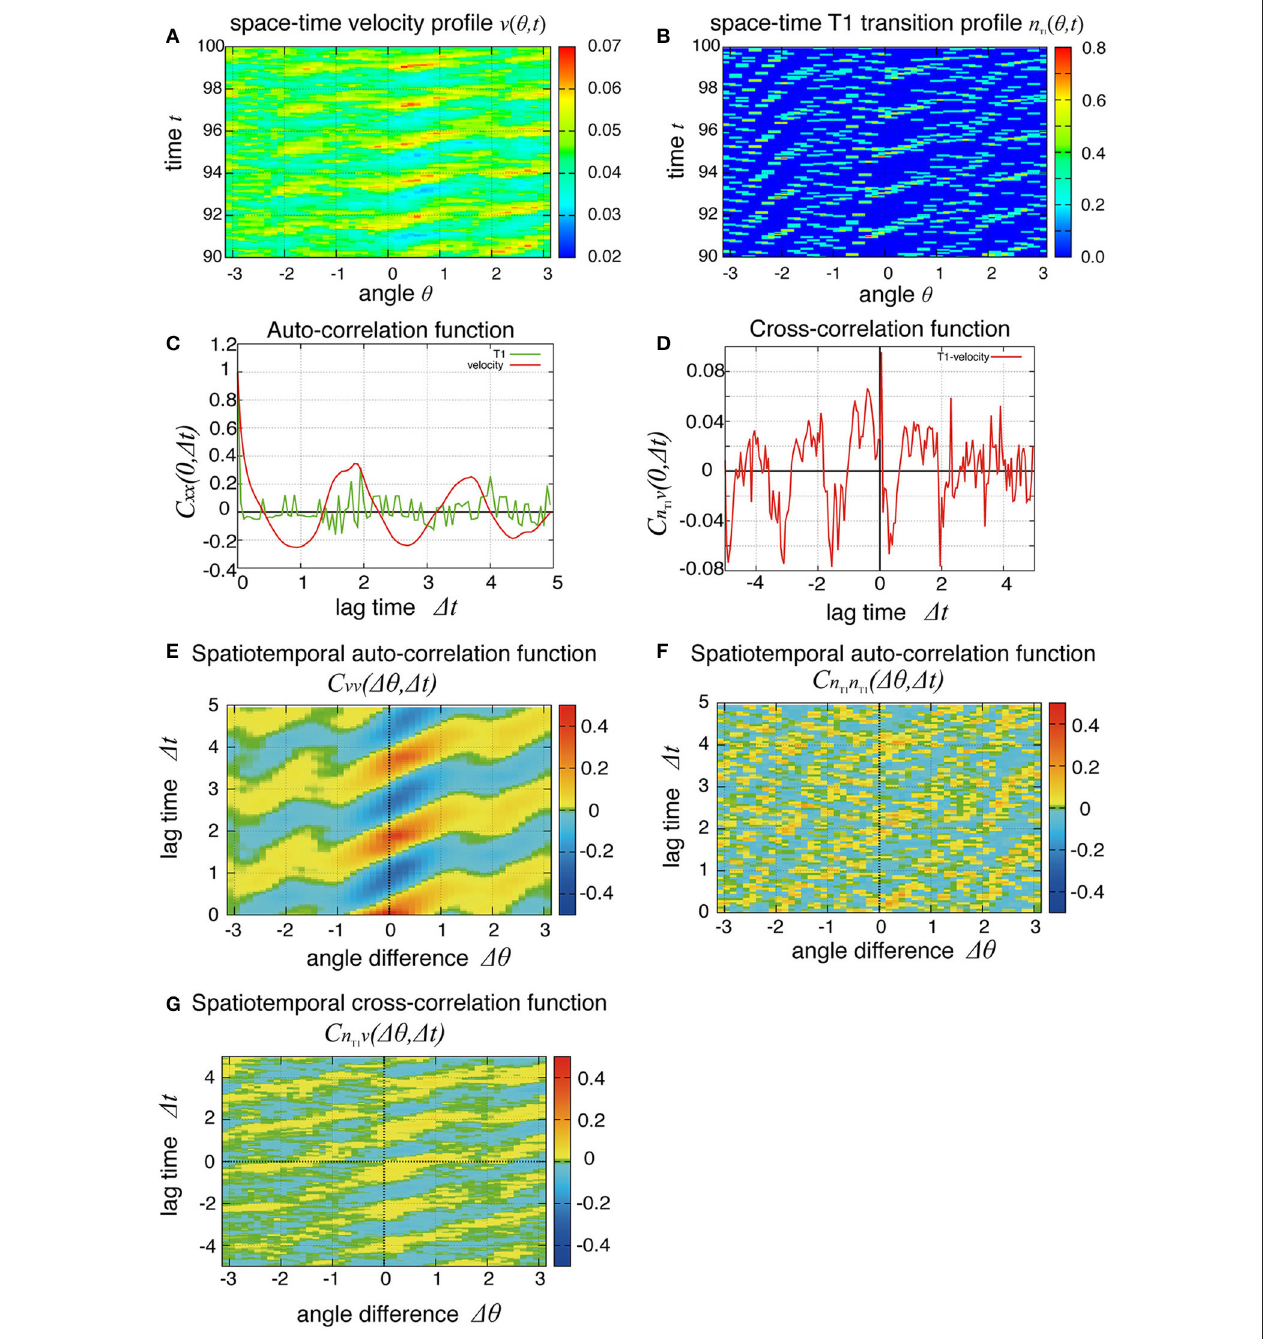
FIGURE 4 | Spatial propagations of cellular motility and T1 transition frequency. (A,B) Spatiotemporal distributions of local angular velocities (A) and frequency of T1 transitions (B) for K p 7.5. (C–G) Spatiotemporal correlation functions for K p 7.5 in the absence of oscillation of chiral line tension. A schematic explanation of = = spatiotemporal correlation function is shown in Supplementary Figure 1 . (C) Temporal auto-correlation of the local angular velocity (red line) and the T1 transition (green line). (D) Temporal cross-correlation function. (E) Spatiotemporal auto-correlation of the local angular velocity. (F) Spatiotemporal auto-correlation of the local frequency of T1 transition. The max/min color was plotted when the color value exceeded the max/min of the color bar. (G) Spatiotemporal cross-correlation C n T1 v ( ∆θ , ∆ t ) δ n T1 ( θ , t ) δ v ( θ ∆θ , t ∆ t ) /σ n T1 σ v between fluctuations of the local angular velocity and the frequency of T1 transition. θ and ∆θ here are defined = h + + i in the clockwise direction. (F,G) The auto-correlations (F) and the cross-correlations (G) along the time axis of ∆θ =